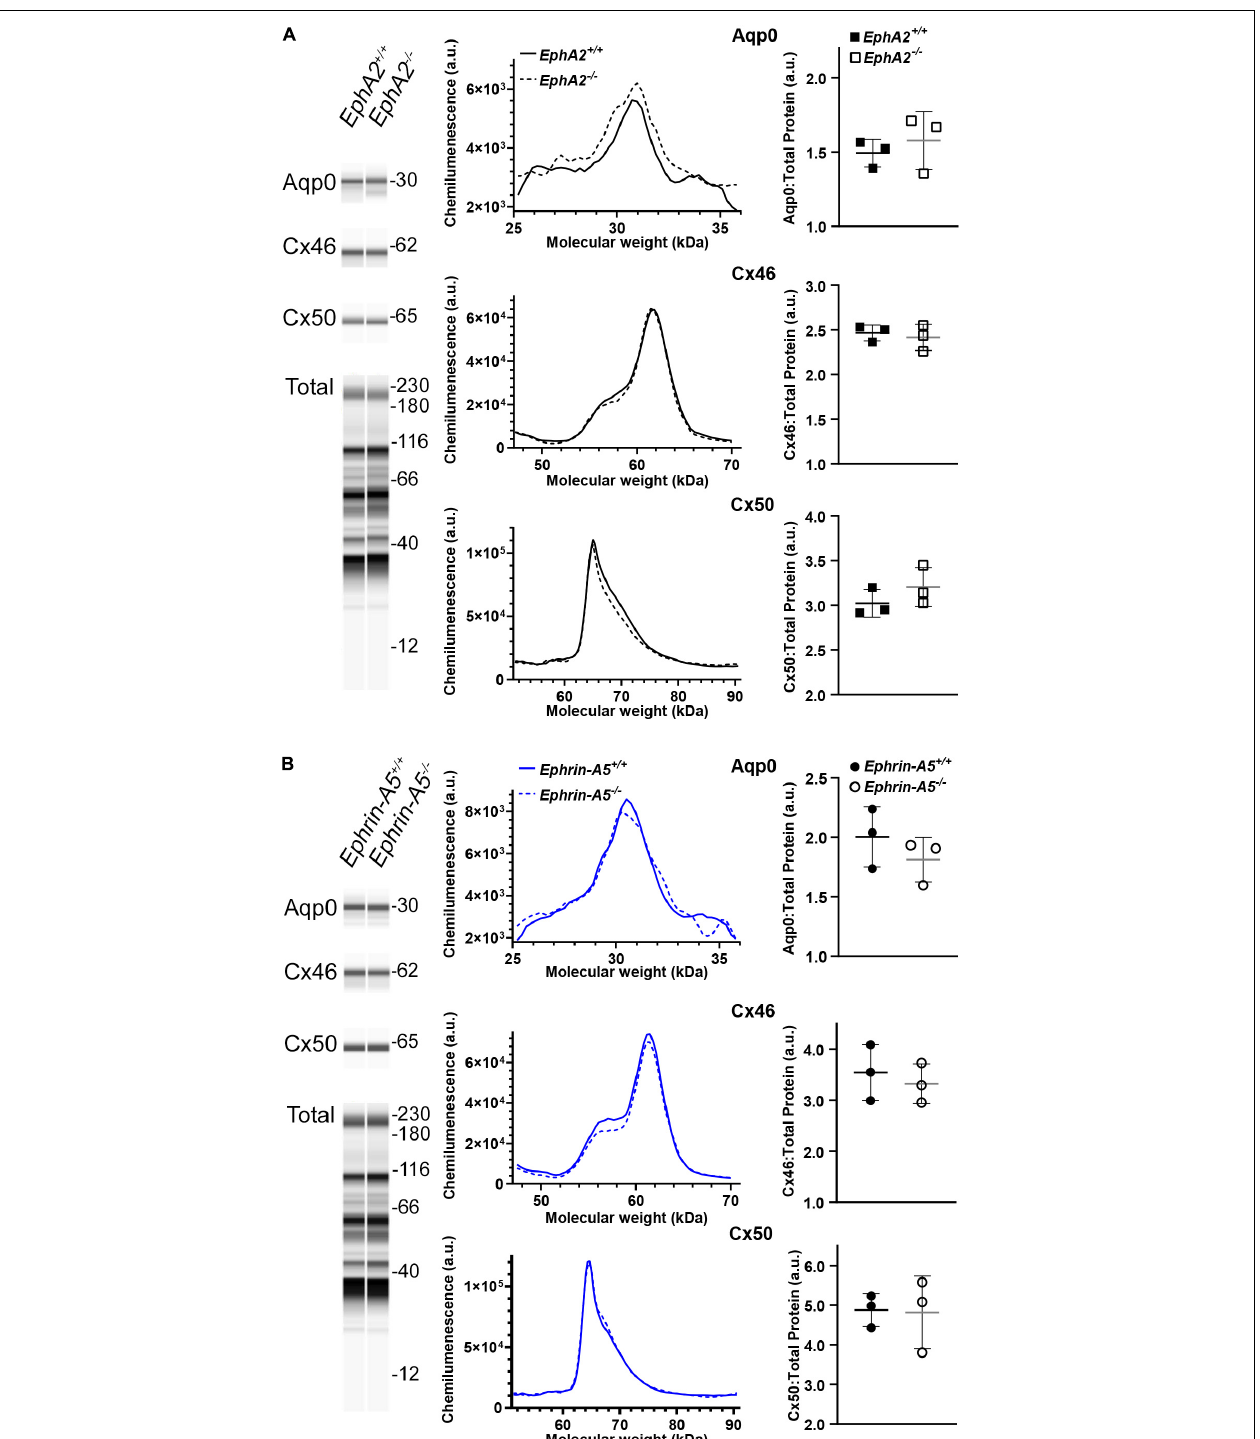
FIGURE 6 | WES capillary-based Westerns for Cx46, Cx50, and Aqp0 in whole lens protein lysates from 6-week-old control, EphA2 − / − and ephrin-A5 − / − lenses. Representative gel bands for Aqp0 (30 kDa), Cx46 (60 kDa), and Cx50 (64 kDa) and total protein profiles (12–230 kDa) are shown in pseudo-lane views. (A) Representative electropherogram of Aqp0, Cx46, and Cx50 peaks are plotted for control and EphA2 − / − samples. Dot plots show the average and standard deviation of Aqp0, Cx46, and Cx50 protein levels normalized to the total protein. There is no difference detected between control and KO lenses in the protein amount for Aqp0, Cx46, and Cx50 ( p > 0.3). (B) The same analysis was conduced for control and ephrin-A5 − / − lenses. There were no statistically significant differences in Aqp0, Cx46, or Cx50 protein levels